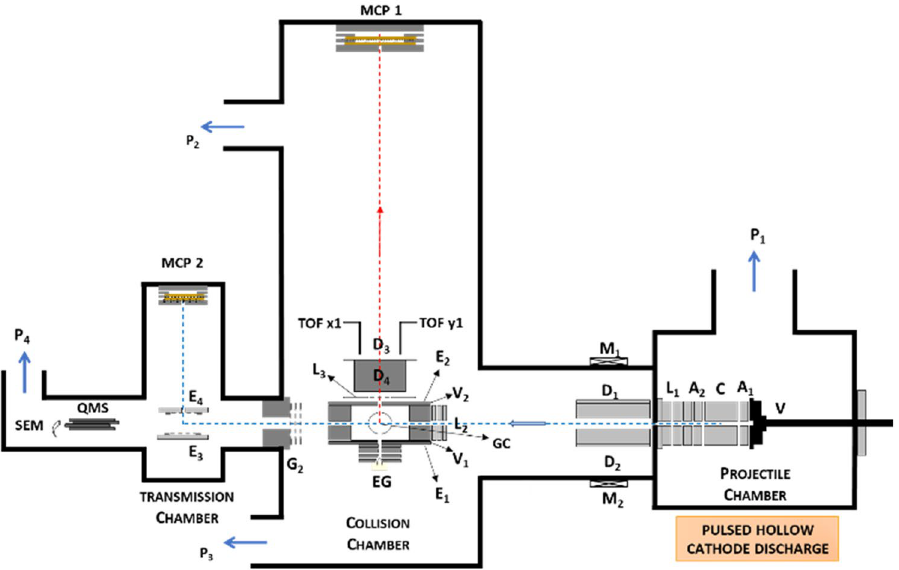
Figure 1. Schematics of the experimental setup. V, pulsed supersonic valve; C, hollow cathode discharge; A1 and A2, anodes (grounded); L1, L2, and L3, Einzel lenses; D1, D2, D3, and D4, deflecting plates; M1 and M2, magnets; E1, E2, E3, and E4, extraction plates; V1 and V2 voltage chamber; G2, retarding field analyzer grids; EG, electron gun; GC, gas cell; MCP 1 and MCP 2, multichannel plate detectors; QMS, quadrupole